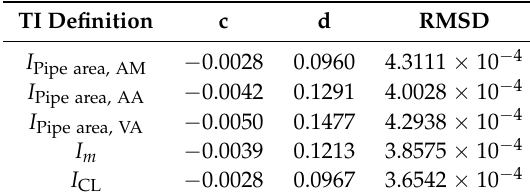
Table 4. Log-law fit constants, rough pipe.